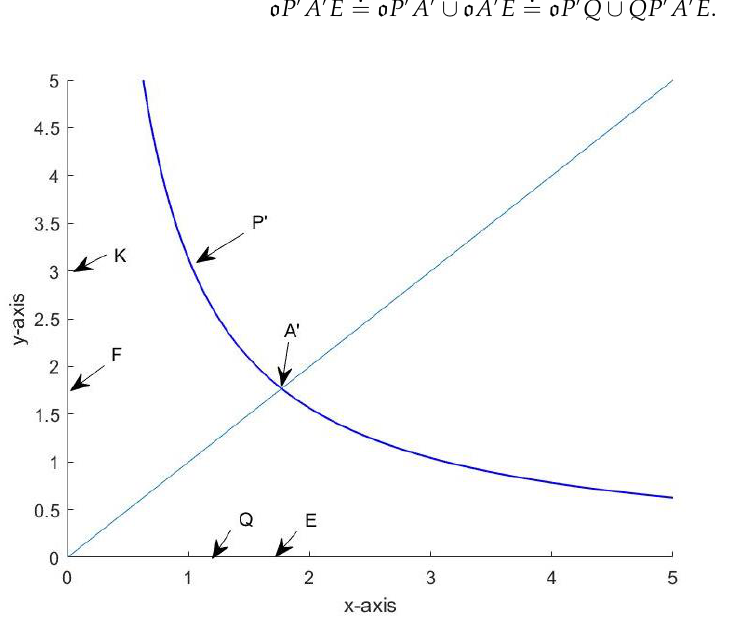
Figure A1. y = 3.25